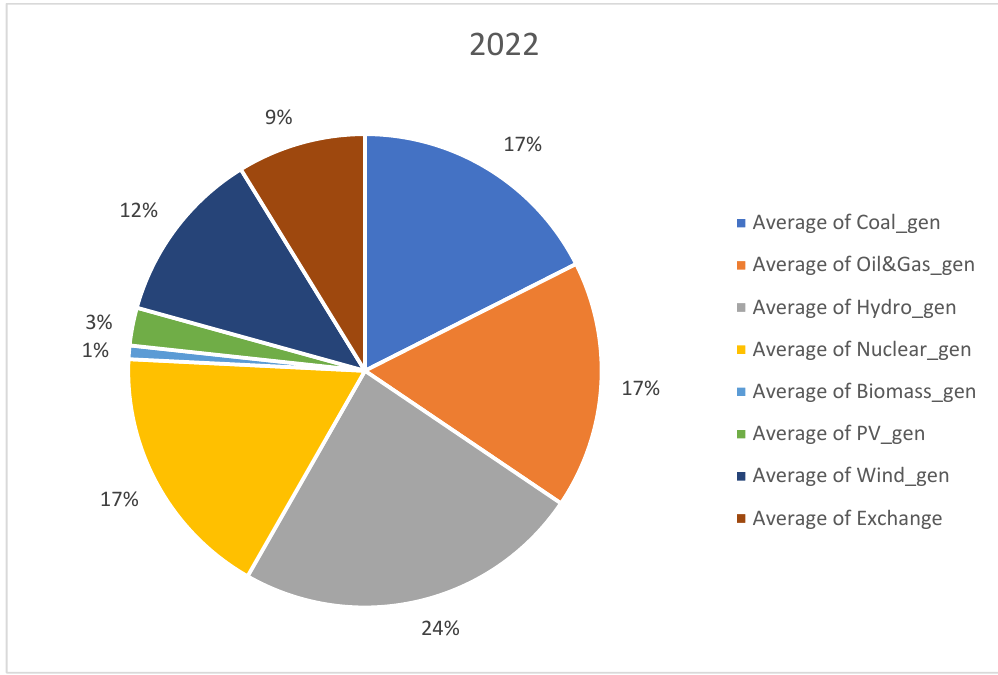
Figure 4. Distribution of generation sources in 2022.